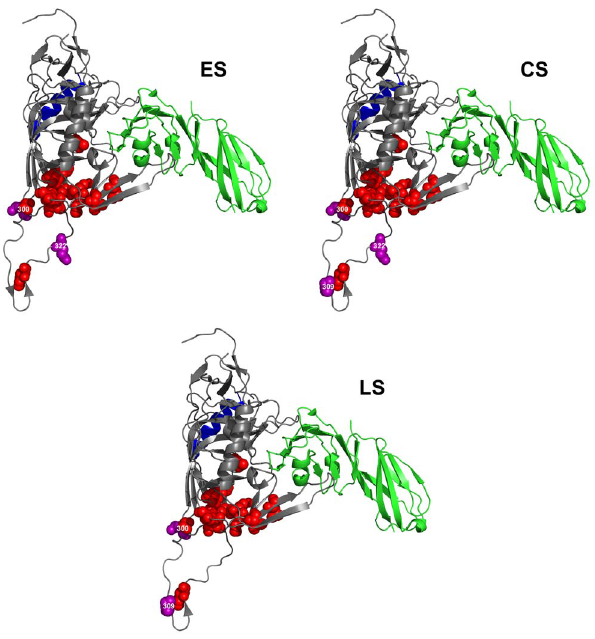
Figure 6. Sites under positive selection pressure in V3 region at different disease stages. HIV-1 gp120 protein model is from JR-FL strain [45]. Sites under selection pressure are indicated as spheres in purple. Labeling of each positively selected site is centered on the a - carbon of the amino acid. CD4 receptor is in green. Residues involved in CCR5 binding are indicated as spheres in red. The a 2 helix region is indicated in blue. Amino acid residue 300 in V3 is partially hidden by residue 441 of the C4 region, to which it is spatially close. Amino acid numbering is according to HXB2 sequence. ES = Early disease Stage CS = Chronic disease Stage LS = Late disease Stage.